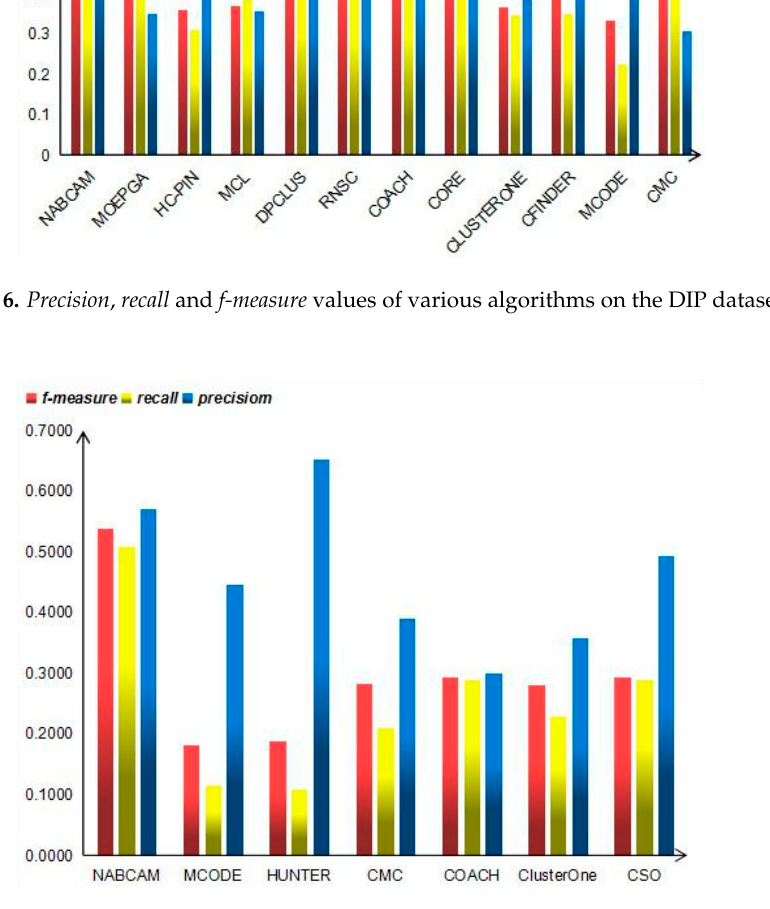
Figure 7. Precision , recall and f-measure values of various algorithms on the MIPS dataset.